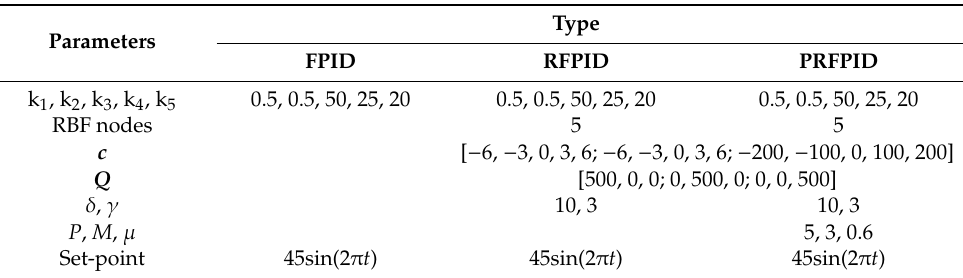
Table 10. Controller parameters of sine response.